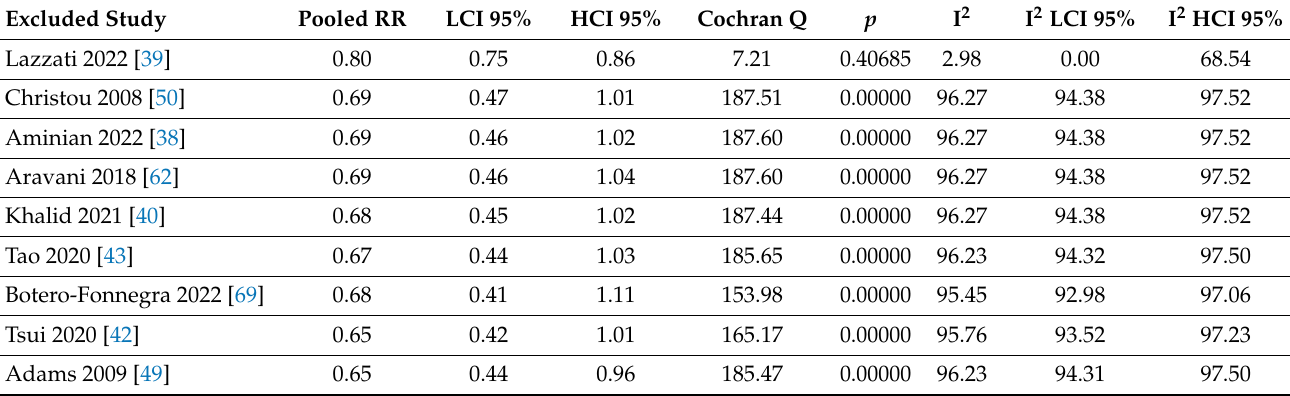
Figure A15. Gallbladder cancer random e ff ects model funnel plot.